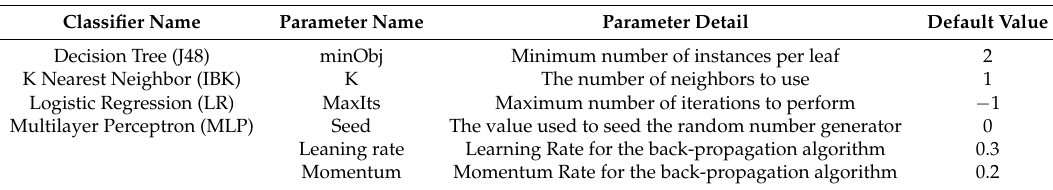
Table 4. Classifiers and their tuning